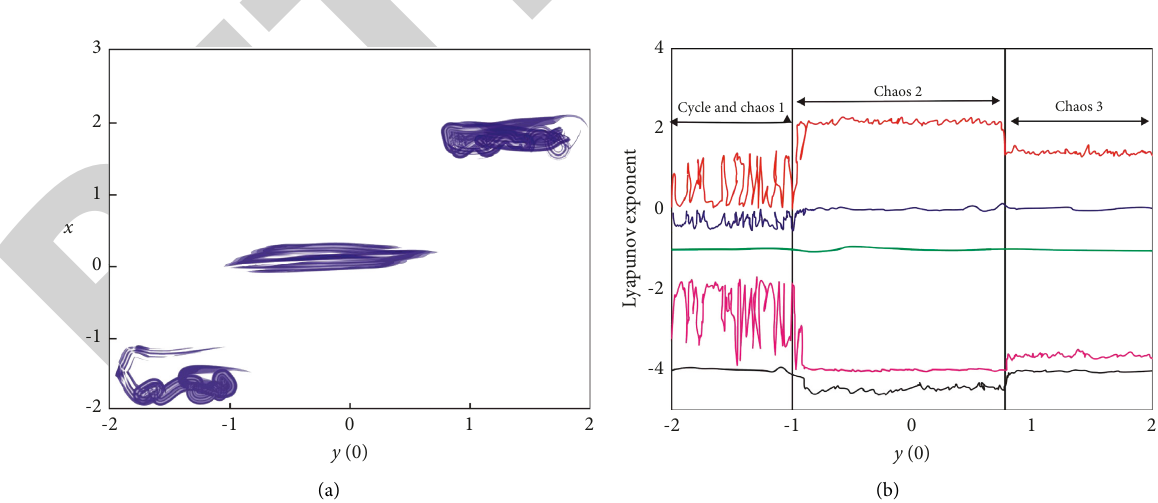
Figure 8: The branch graph and Lyapunov exponent spectrum of the system with the initial value y (0): (a) branch graph; (b) Lyapunov exponent spectrum.